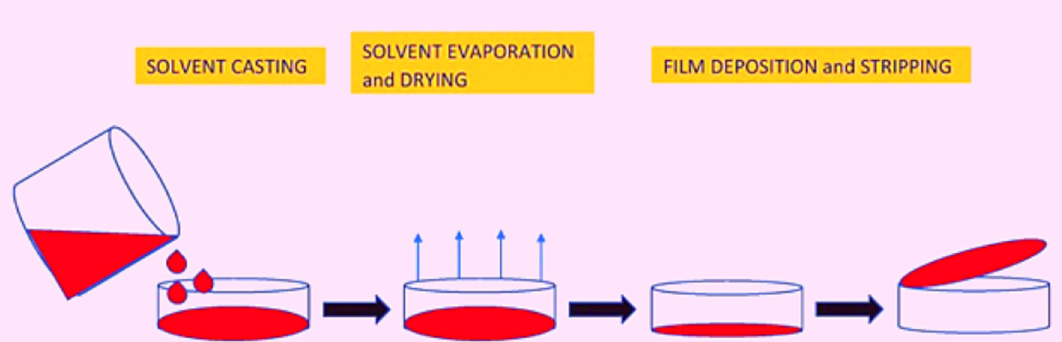
Figure 4. Several steps in the casting procedure for edible film formation. Adopted from [194] with permission.